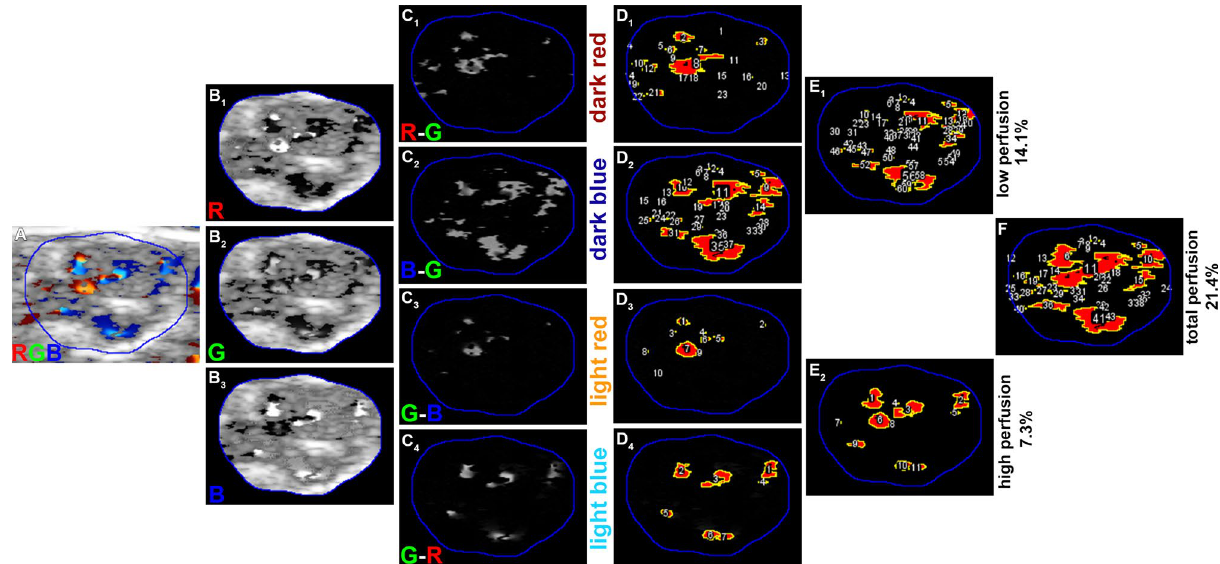
Figure 2. Exemplary analysis of color Doppler neurosonographs and subsequent signal selection. The color Doppler image ( A ) was split into the red, green and blue channel ( B ) and image subtraction steps were performed ( C ) followed by subsequent signal selection via “MaxEntropy”-thresholding and signal selection ( D ). Since the direction of blood flow is not analyzed, the low velocity perfusion signals ( D 1 , D 2 ) as well as the high velocity perfusion signals ( D 3 , D 4 ) were merged via maximum projections, resulting in direction-independent low velocity perfusion signals ( E 1 ) and high velocity perfusion signals ( E 2 ). For quantification of the total perfusion, these signals were merged via maximum projections respectively ( F ).